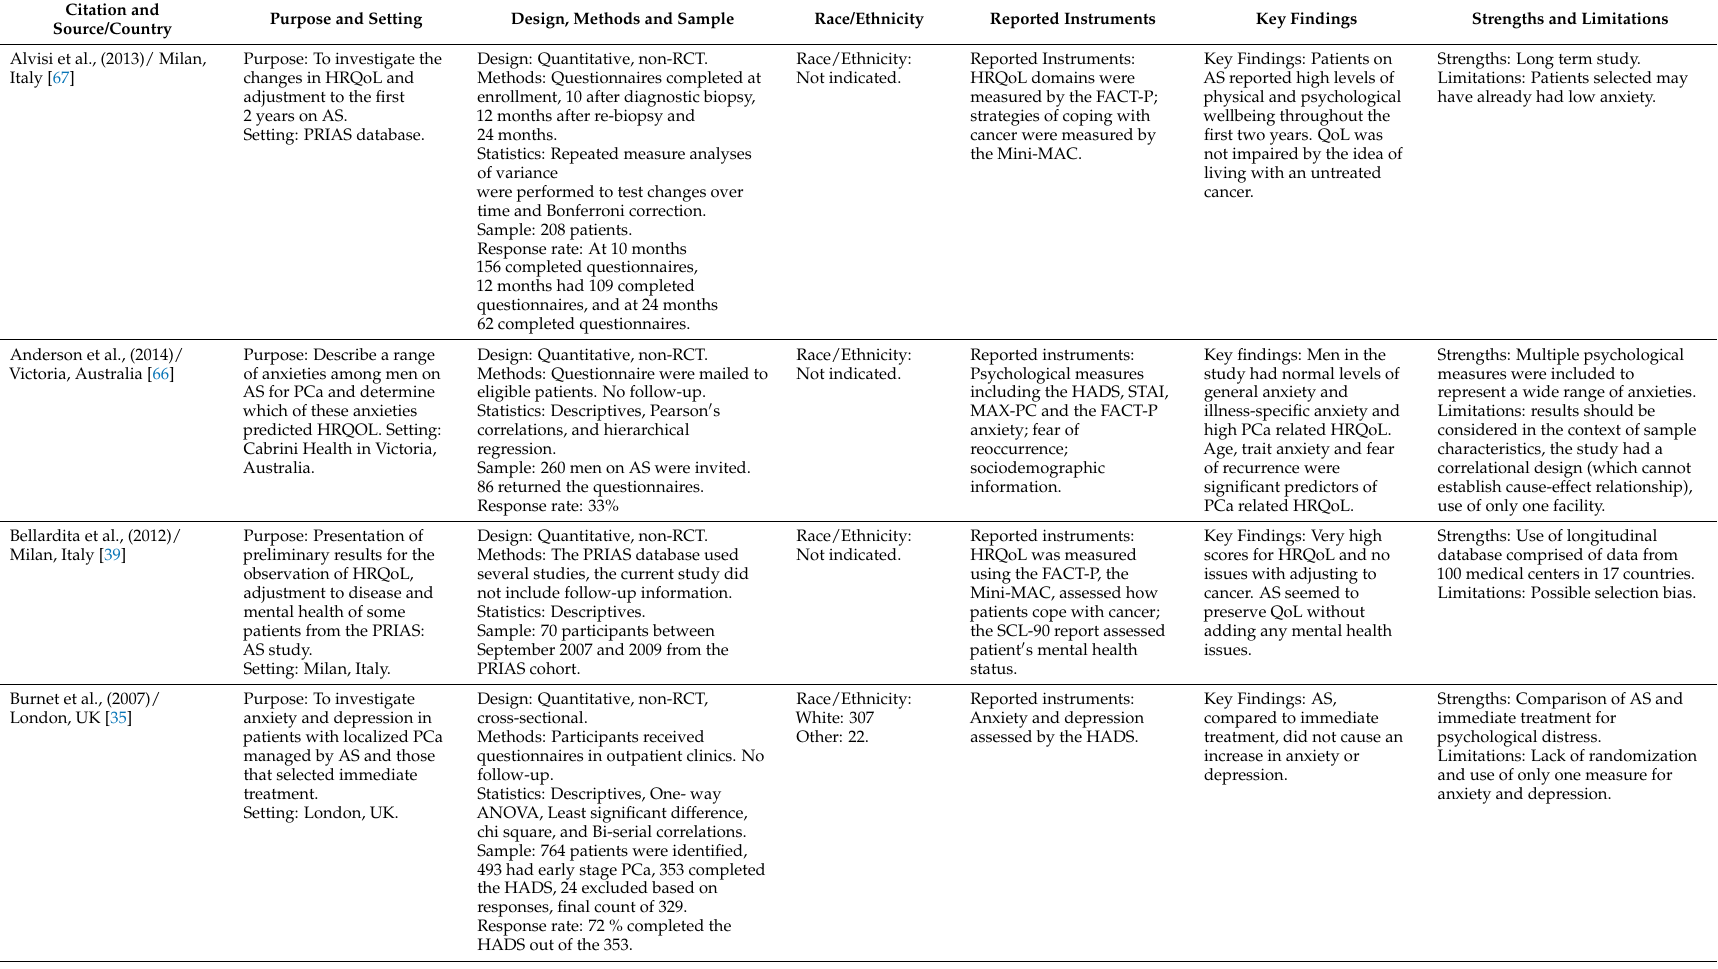
Table 2. Anxiety and depression among men utilizing active